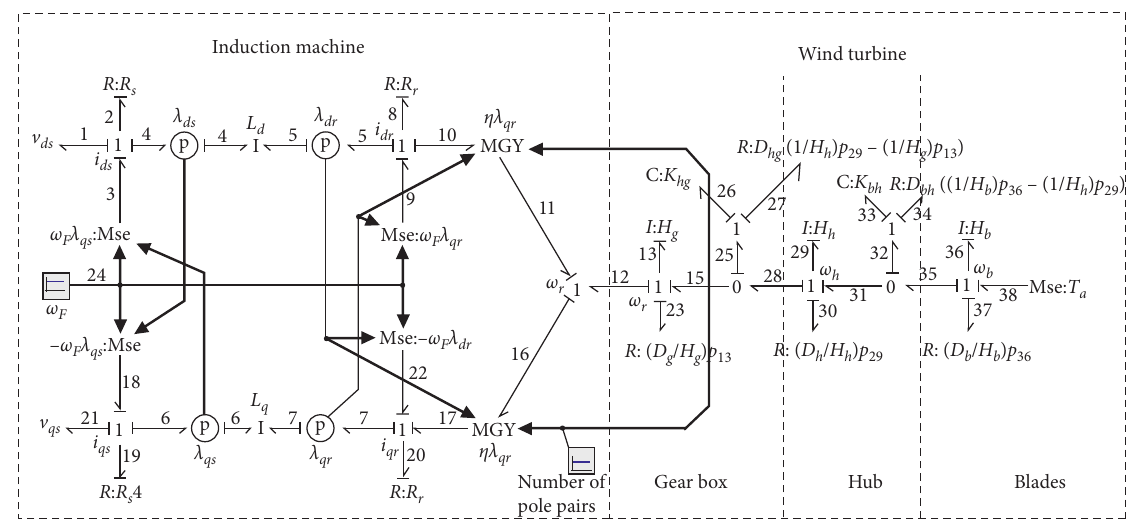
Figure 8: Bond graph with a derivative causality assignment for the fast dynamics of the wind